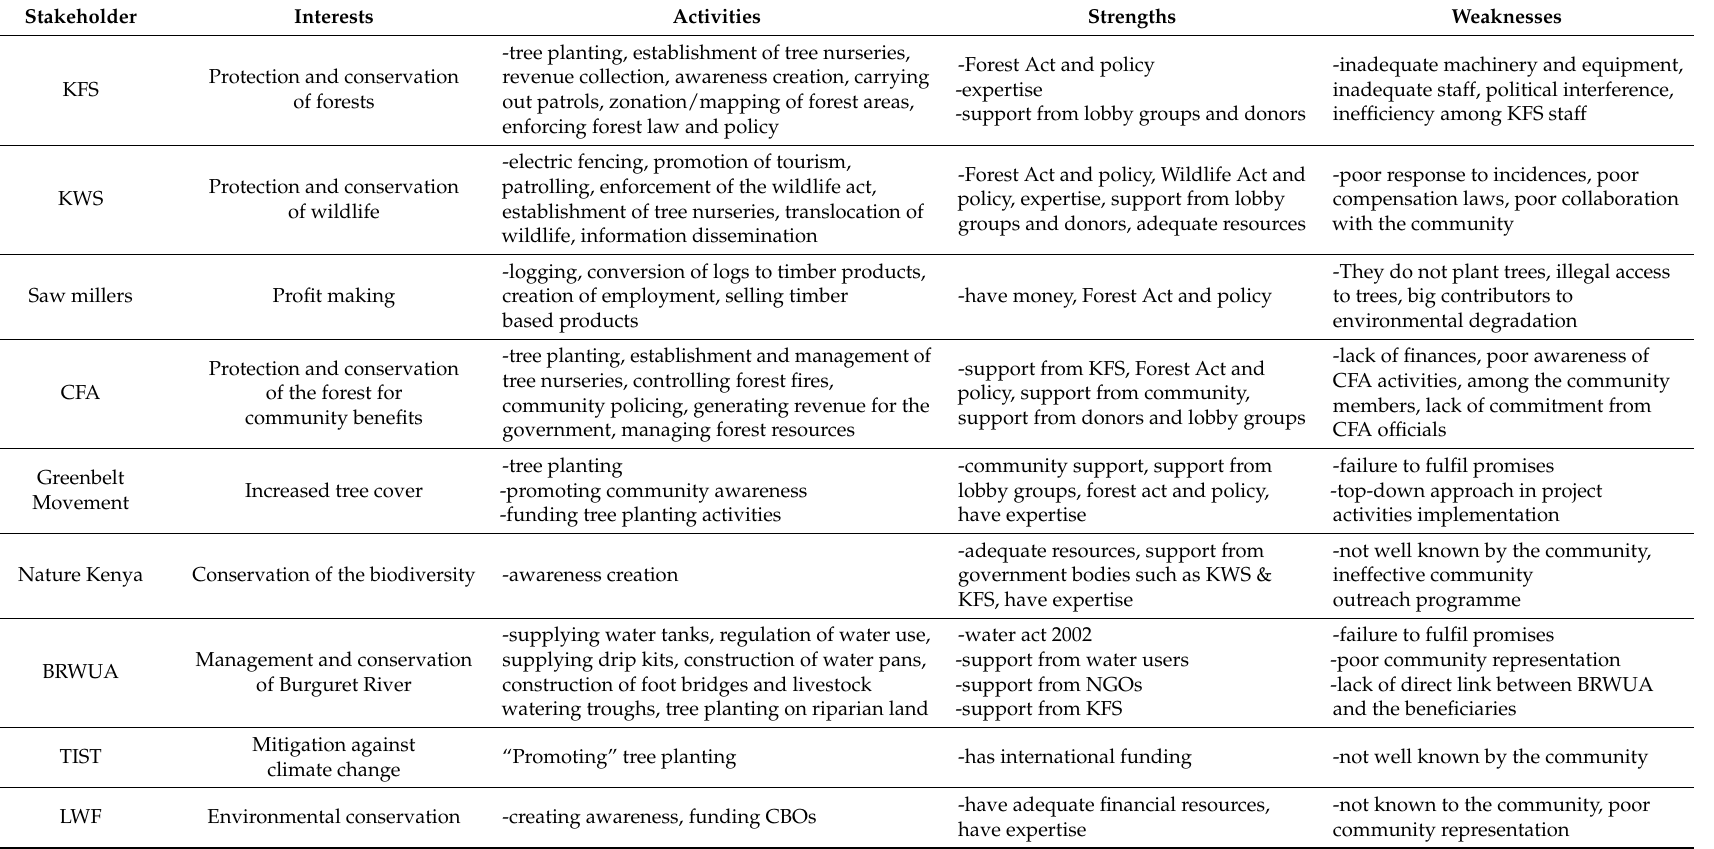
Table A1. Stakeholders Involved in the Management of Gathiuru